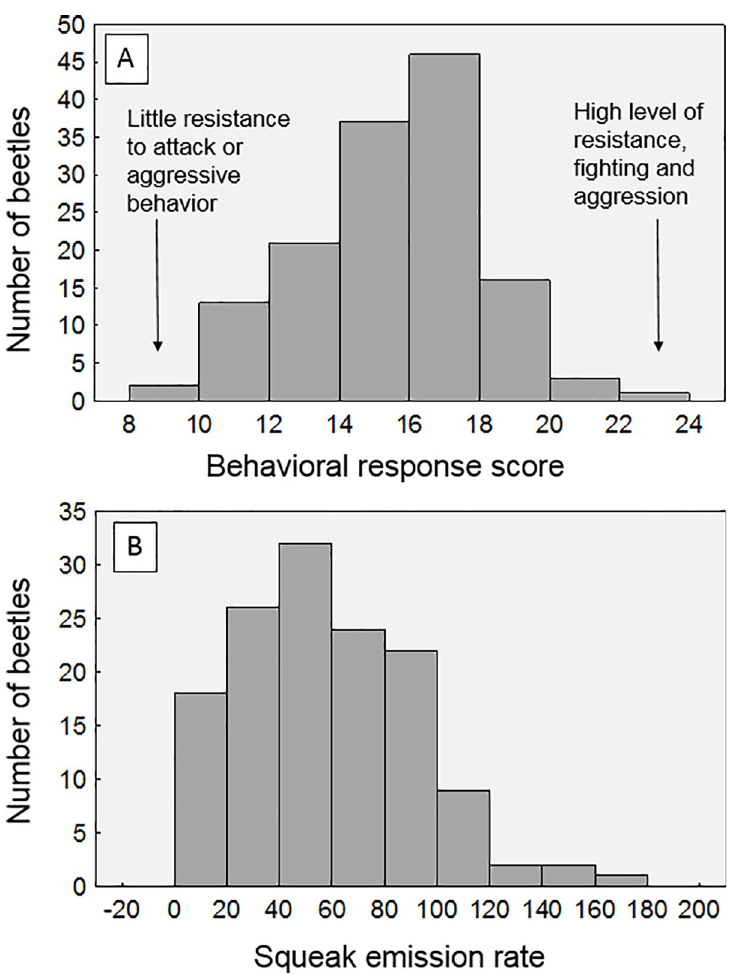
Fig 3. Distribution and range of behavioral responses. Shown are the range of behavioral reaction scores (A) and squeak emission rates (B) during simulated attack for all beetles in this experiment (n = 140).